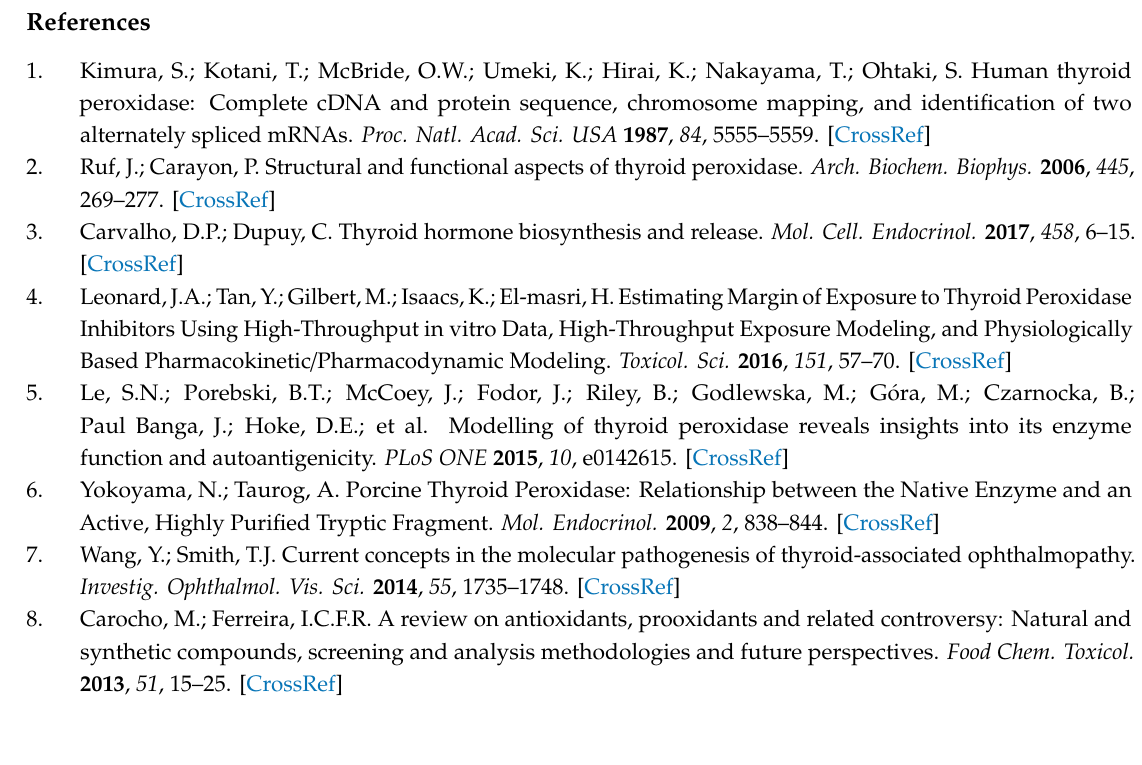
Supplementary Materials: The following are available online, Figure S1: A—Homology model of TPO. Protein shown in cartoon representation with subunits colored light and dark blue. Disulfide bridges depicted as spheres with yellow sulfur atoms. Heme molecules in the MPO domain presented as spheres with magenta carbon atoms. B—The Ramachandran plot for the homology model of TPO. Glycine residues shown as triangles and proline residues as squares. C—3D view of heme binding site at TPO. Heme molecule shown as sticks with magenta carbon atoms. Protein presented in wire representation with grey carbon atoms. Most important residues shown as sticks. Hydrogen bonds depicted as red dashed lines. Non-polar hydrogen atoms omitted for